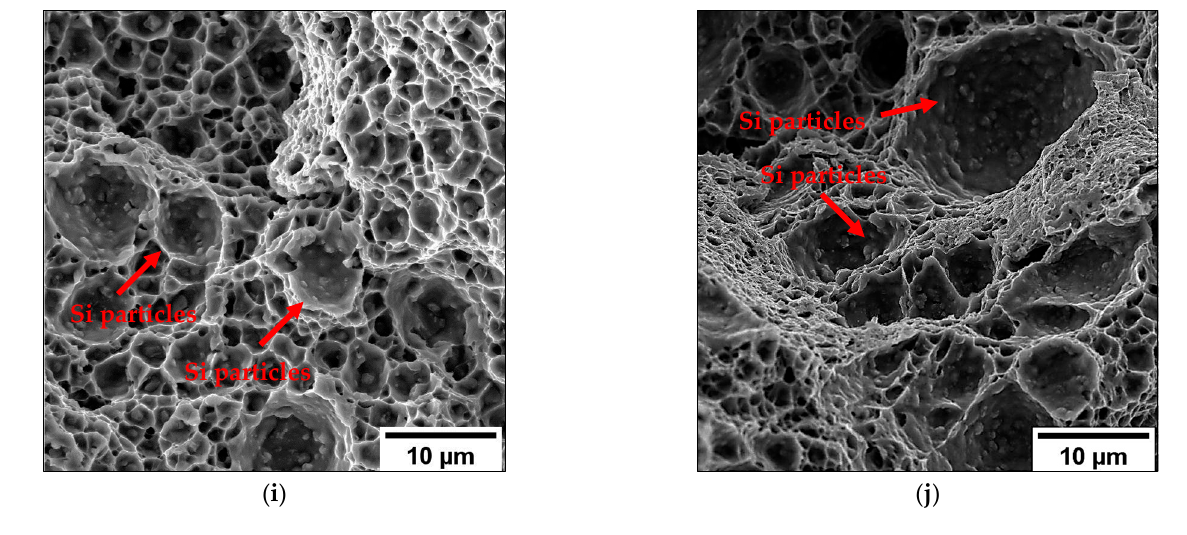
Figure 13. SE image of the T6R ‐ RT ( a , c , e , g , i ) and T6R ‐ 200T ( b , d , f , h , j ) specimens. Killer defect ( a , b ); crack propagation ( c , d ); micro ‐ tearing in the fatigue propagation region ( e , f ); final overload fracture ( g , h ); dimple voids ( i , j ). Red arrows show the Si particles inside large dimples.